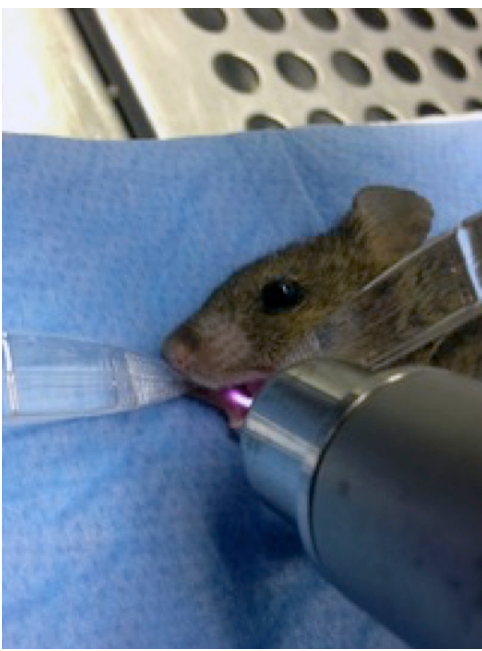
Fig 3. Plasma treatment (kINPen09). Treatment of the right cheek of a narcotized mouse.